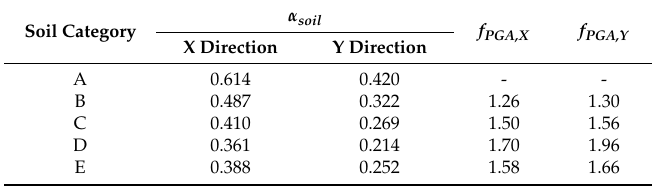
Table 4. The effect of the topographic class variation on the local seismic amplification factor.